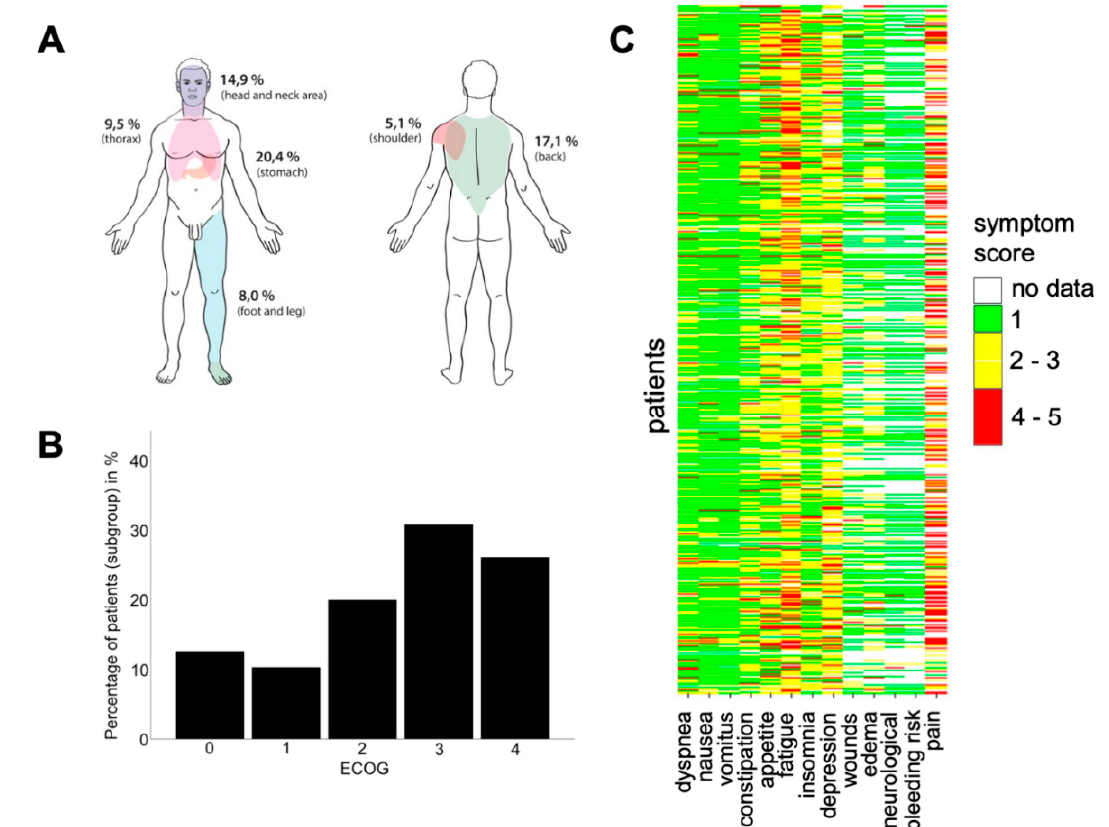
Figure 2. Evaluation of pain location, the burden of presented symptoms, and the ECOG performance status of referred patients at the first consultation with PCCS. Schematic overview of frequencies for the different pain locations of referred patients ( A ). ECOG status (0–4) of referred patients ( B ). Heatmap showing the burden of symptoms presented at the first PCCS consultation on a scale of stable (1), slightly reduced (2), reduced (3), greatly reduced (4) and unbearable (5) ( C ).